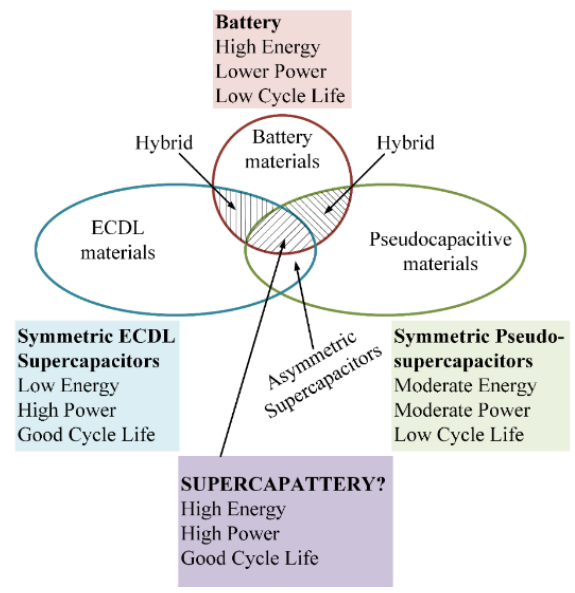
Figure 62. Merging the characteristics of EDLC, pseudocapacitive, and battery materials in battery type hybrid supercapacitors [185]. Table 12. Different hybrid supercapacitor electrode materials (MWCNT—multiwalled carbon nanotubes; CNTA—carbon nanotube arrays; PAN—polyacrylonitrile) [59].